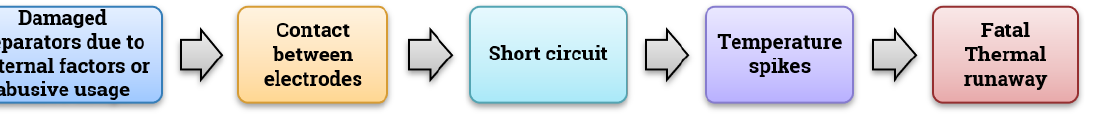
Figure 7. Separator failure mechanism.